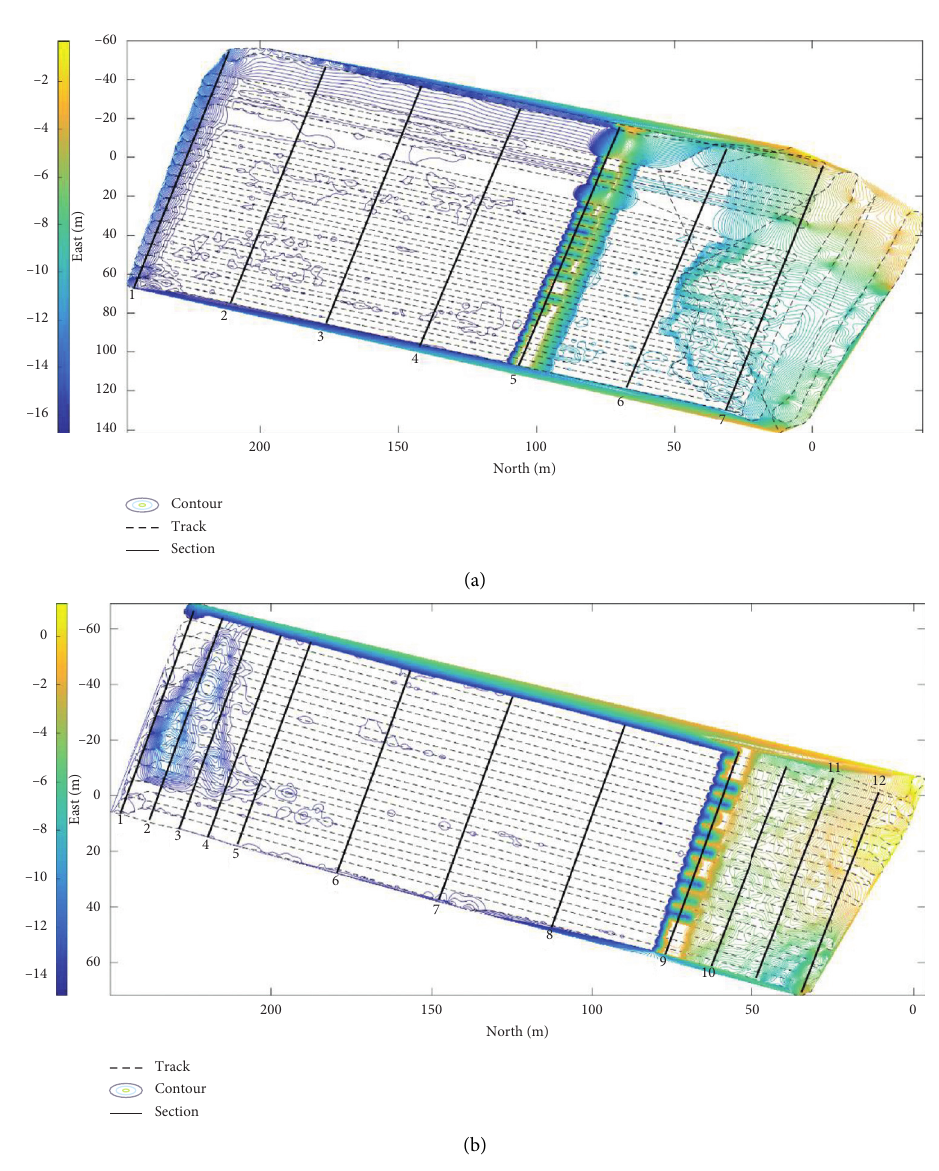
Figure 10: Underwater topographic contour lines and selected sections of the stilling basin. (a) Surface outlet stilling basin. (b) Bottom outlet stilling